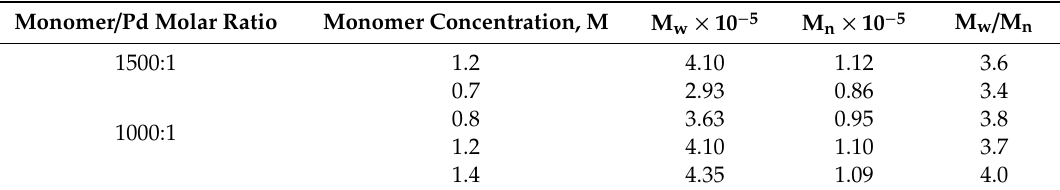
Table 2. Addition polymerization of 3-pentafluorophenyltricyclononene-7 (the catalyst was Pd(OAc) 2 /PCy 3 /NaBARF, the Pd(OAc) 2 /PCy 3 /NaBARF molar ratio was 1:2:5, [monomer] = 0.7 M, the solvent was chloroform, 24 h, T = 30 °C).